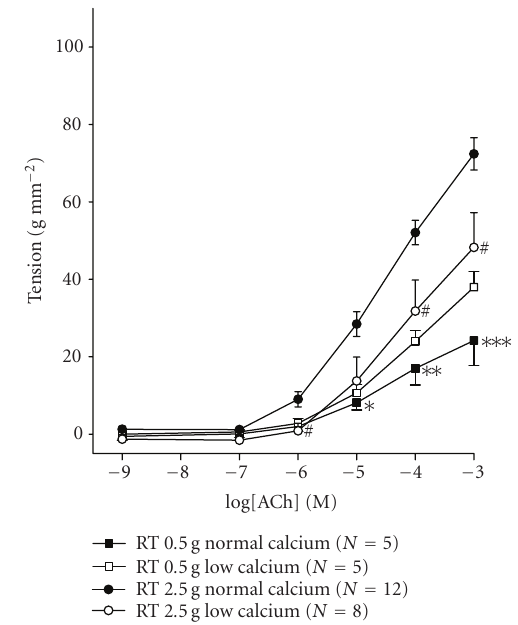
Figure 1: Concentration-e ff ect curves for acetylcholine, performed in normal and low extracellular calcium concentration Krebs solu- tion, at 0.5 g (squares) and 2.5g (circles) RT. Data are means from 5 to 12 experiments and vertical lines show SE. # P < . 05: com- parison between values of tension at low and normal extracellular calcium concentrations, obtained at 2.5 RT. ∗ P < . 05, ∗∗ P < . 01, and ∗∗∗ P < . 001: comparison between values of tension obtained at 0.5g and 2.5 g RT at normal extracellular calcium